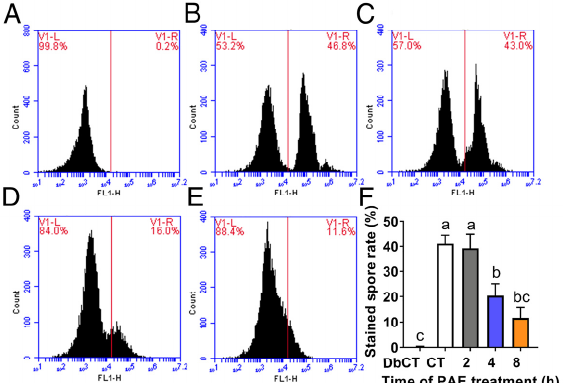
Figure 5. Distribution of fluorescence intensity values of mitochondrial membrane potential (MMP) in F. solani detected by Rh123 staining. Spores were exposed to 1.5 mL/L PAE for 0 as control (CT) ( B ), 2 ( C ), 4 ( D ) and 8 ( E ) h. The spores that were stained with water instead of Rh123 were served as a dye-blank control (DbCT) ( A ). Bar graph of stained spore rate ( F ). Values are mean ± standard deviations ( n = 3). Different letters indicate statistically significant differences ( p < 0.05) calculated by one-way ANOVA.